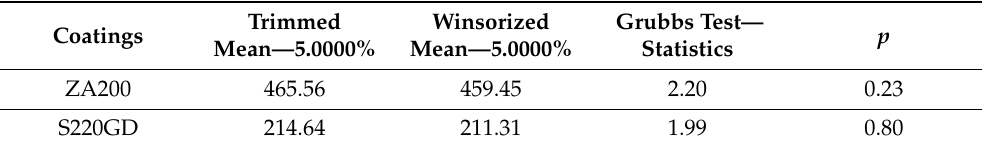
Table 2. Grubbs test results (sliding friction test results).